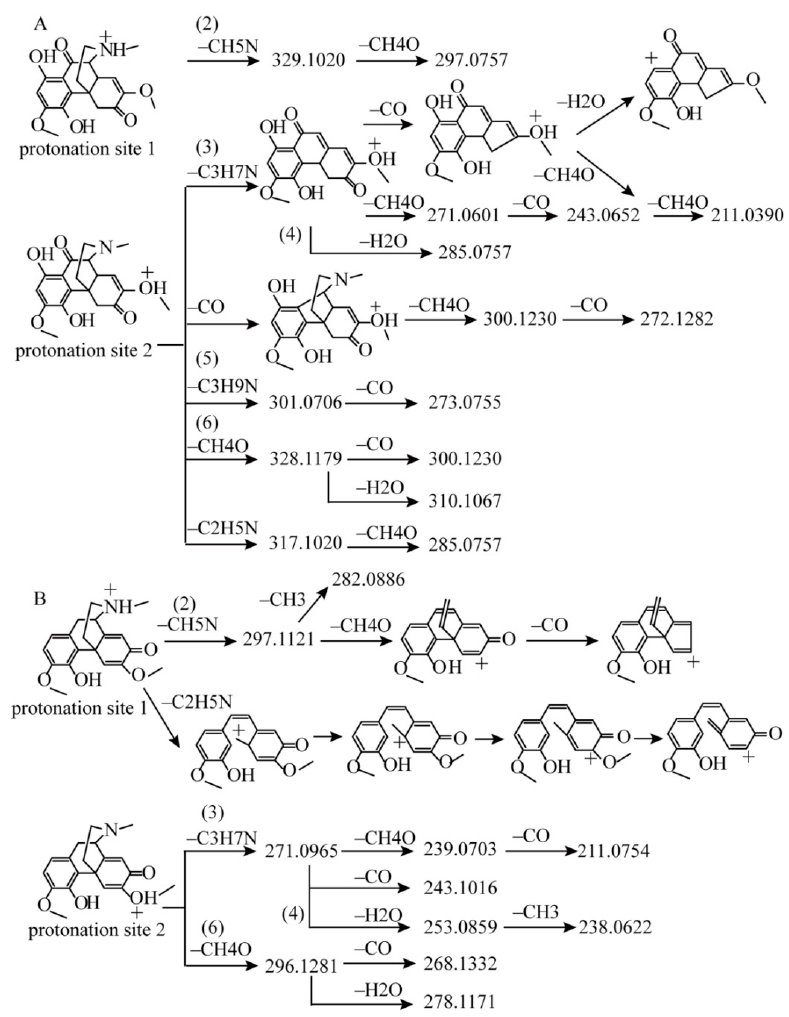
Figure 4. Proposed fragmentation pattern of the protonated ( A ) 1-hydroxy-10-oxo-sinomenine and ( B ) protonated sinoacutine.